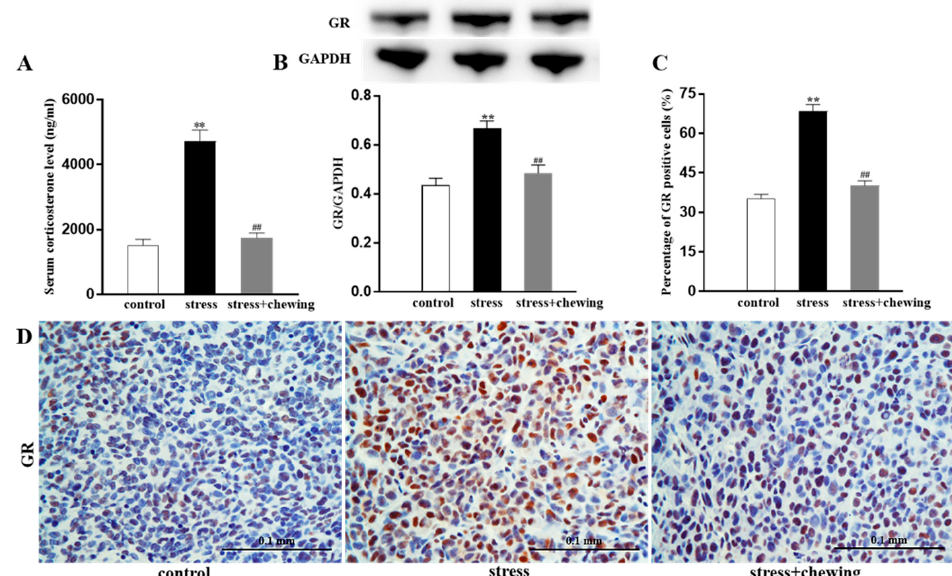
Figure 3. Chewing behavior during psychological stress decreased serum glucocorticoid levels and expression of GR in the tumor. ( A ) Serum glucocorticoid levels. ( B ) The expression level of GR protein in the tumor. ( C ) Percentage of GR-positive cells in the tumor. ( D ) Representative photographs of GR-positive cells in the tumor. (** p < 0.01 vs. control group, ## p < 0.01 vs. stress group, n = 9/group). All data are expressed as mean ± SEM.